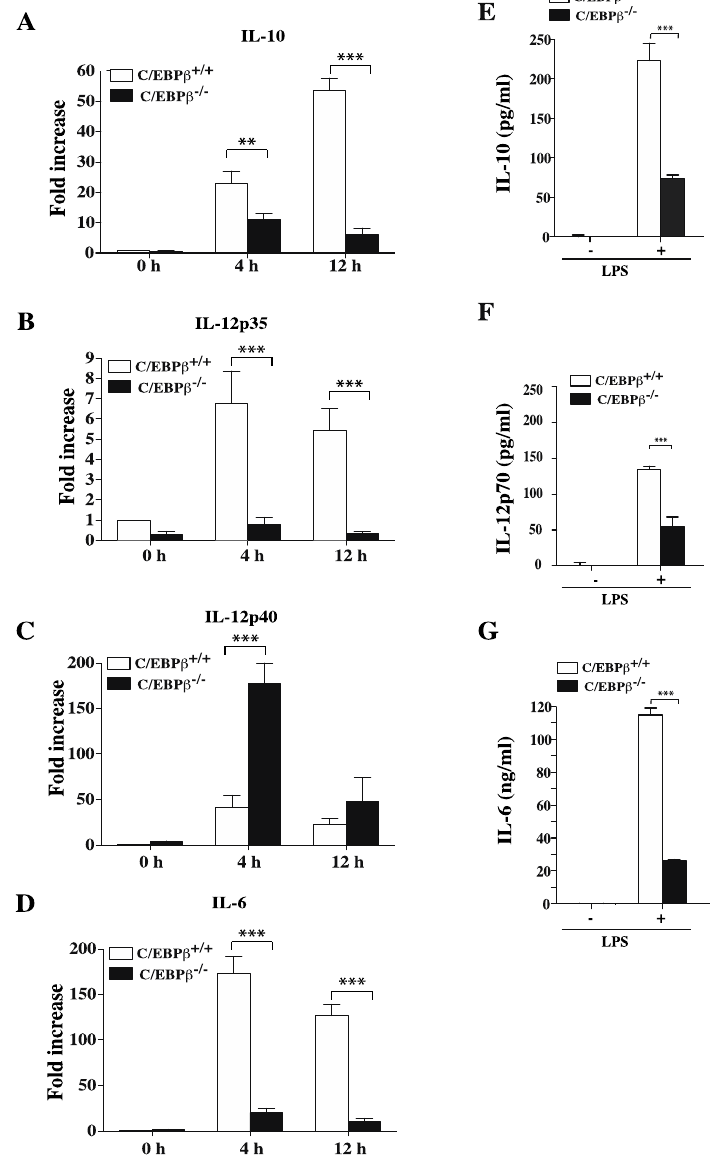
Figure 6. Effect of C/EBPβ deficiency on gene expression and production of IL-10 and IL-12 by GM/DCs. Bone marrow-derived GM/DCs generated from C/EBPβ −/− or C/EBPβ +/+ mice were left unstimulated or were stimulated with 1 μg/mL of LPS for 4 h and 12 h. The expression of IL-10 ( A ), IL12p35 ( B ), IL-12p40 ( C ), and IL-6 ( D ) was determined by real-time PCR. Data are shown as fold increases with reference to unstimulated GM/DCs of C/EBPβ +/+ (t = 0) and are representative of four independent experiments. For cytokines release, bone marrow-derived GM/DCs generated from C/EBP β − / − or C/EBP β +/+ mice were left unstimulated or stimulated with LPS (1 µ g/mL for 24 h). Cell supernatants were collected and IL-10 ( E ), IL-12p70 ( F ), and IL-6 ( G ) production was analyzed by ELISA. Data are representative of three independent experiments and are shown as the mean ± SEM. The asterisks (*) correspond to p < 0.01 (**) and p < 0.001 (***), one-way ANOVA with post hoc Bonferroni’s